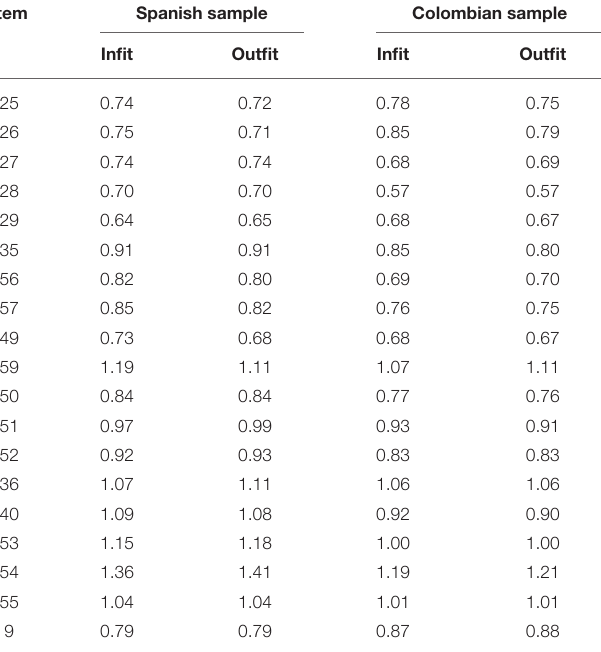
TABLE 1 | Rasch fit statistics for selected